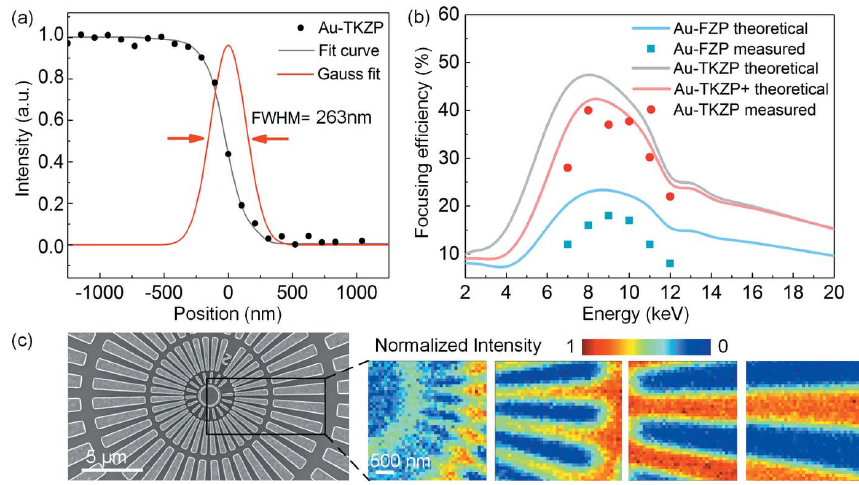
Figure 5 Characterizations of the focusing performance of the fabricated Au-TKZP. ( a ) The focusing beam profiles of the Au-TKZP lens, measured by the knife-edge scanning method with dwell time of 100 ms and step size of 100 nm. The dotted line is the raw data, the solid line in black is the least- squares fitting curve and the red line is the first derivative of the fitted scanning curve, giving rise to a the full width at half-maximum of 263 nm for the Au-TKZP lens. ( b ) The measured focusing efficiencies of Au-TKZP and Au FZP. For comparison, their corresponding theoretical figures are also presented. The efficiency labeled TKZP+ was calculated from the actual zone profiles. ( c ) SEM image (left) of the in-house-made Siemens stars with minimal resolution of 100 nm and X-ray image (right) of the same target at 8 keV with a dwelling time of 100 ms and step size of 150